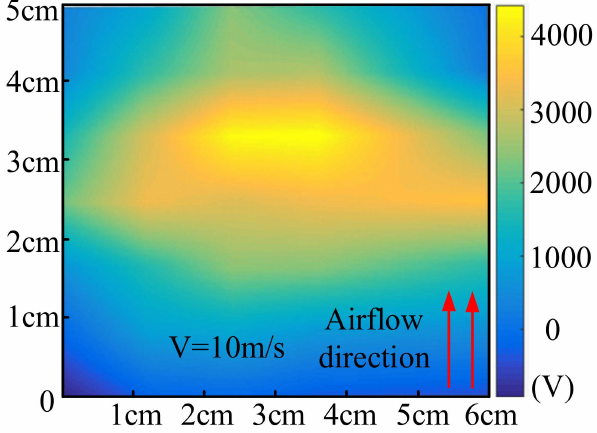
Figure 14. Charge distribution when the air velocity is 10